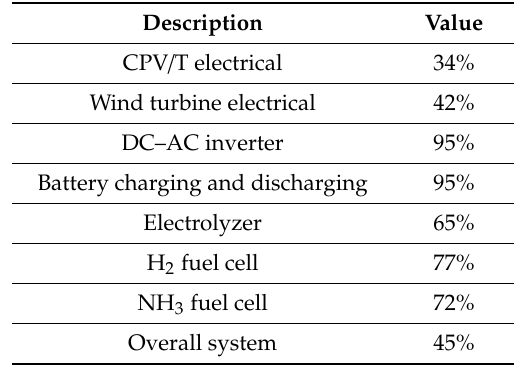
Table 1. E ffi ciencies of the main components and